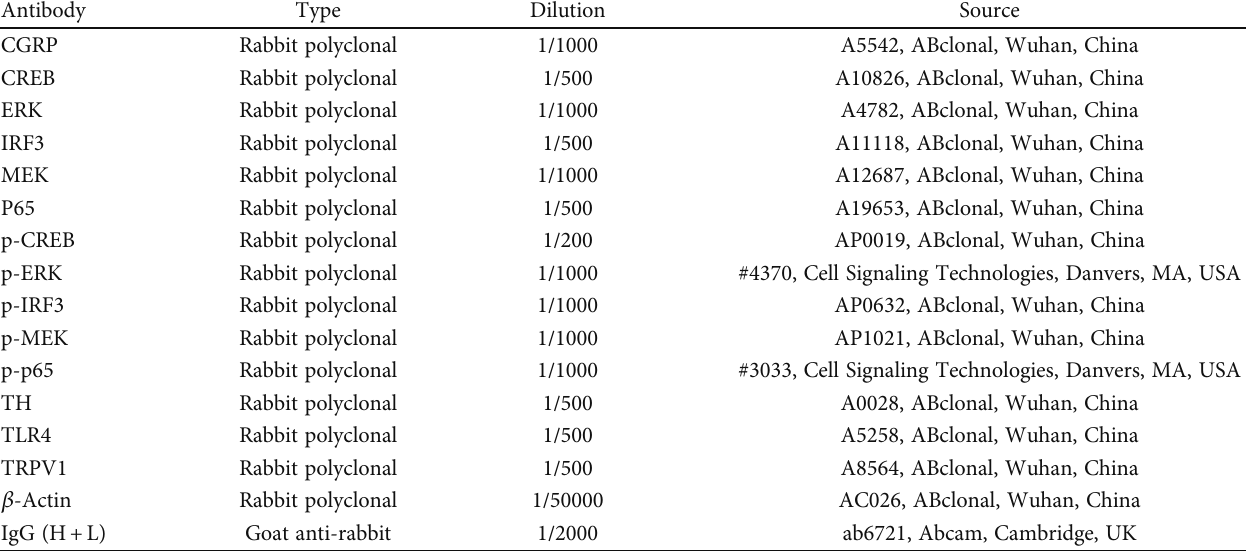
Table 1: Antibodies used for Western blot